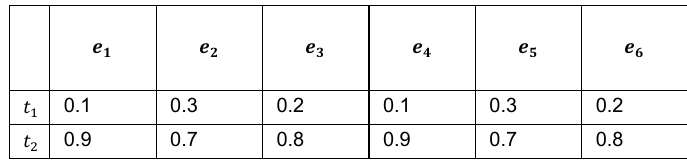
Table 5. Preferences of the six expert